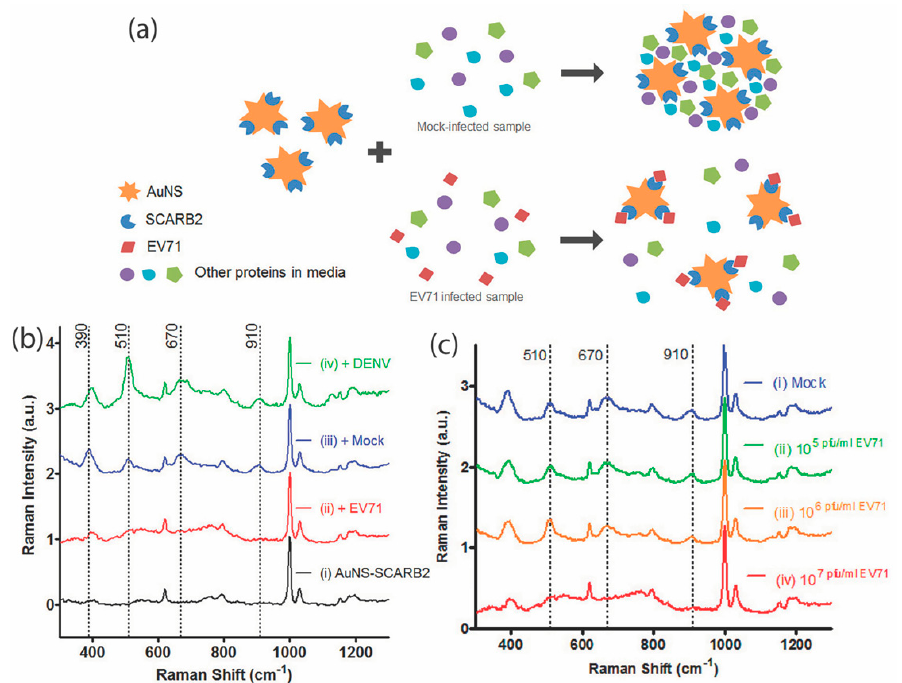
Figure 5. Direct, label-free SERS-based detection of enterovirus 71 using gold nanostars conjugated to recombinant scavenger receptor class B, member 2 (SCARB2) protein. (a) Schematic representation of the enterovirus 71 detection by SCARB2 protein- functionalized gold nanoparticles. (b) SERS spectral differences of AuNS-SCARB2 in the presence of EV71 in comparison to other control proteins, which indicates analytical specificity of this approach and (c) concertation dependence of the SERS intensity of the AuNS-SCARB2- EV71 conjugate. Reproduced with permission from Reference [101] American Chemical Society (2011).